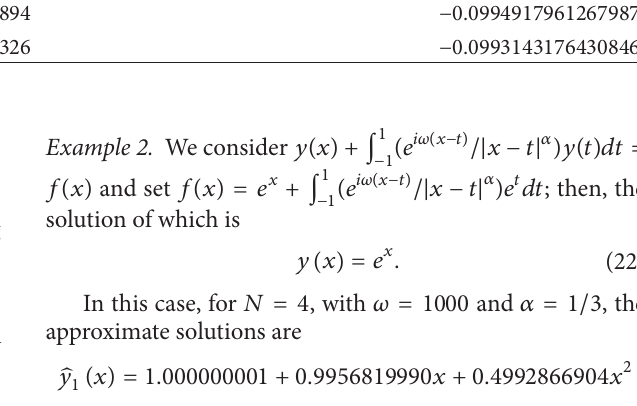
Table 1: Approximations for 𝑦(𝑥) + ∫